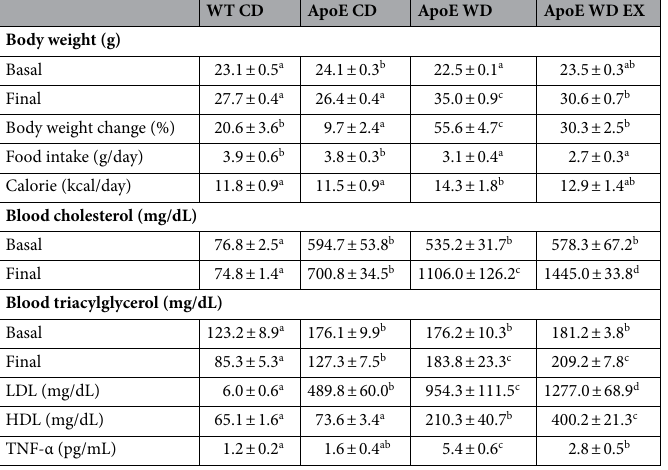
Table 1. Body weight, blood lipids, and cytokine profiles. Values are mean ± SEM ( n = 6). Different superscript (a, b, c, d) letters indicate significant differences ( P < 0.05) in one-way ANOVA. Body weight changes were calculated using the ratio of the baseline weight to the final body weight. LDL low-density lipoprotein, HDL high-density